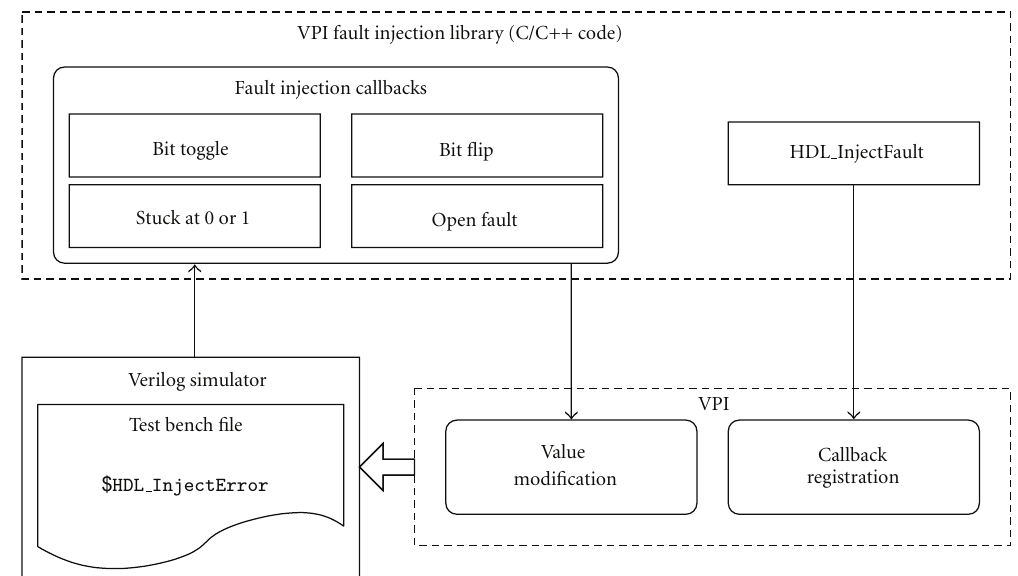
Figure 8: Block diagram of VPI simulation and fault injection flow